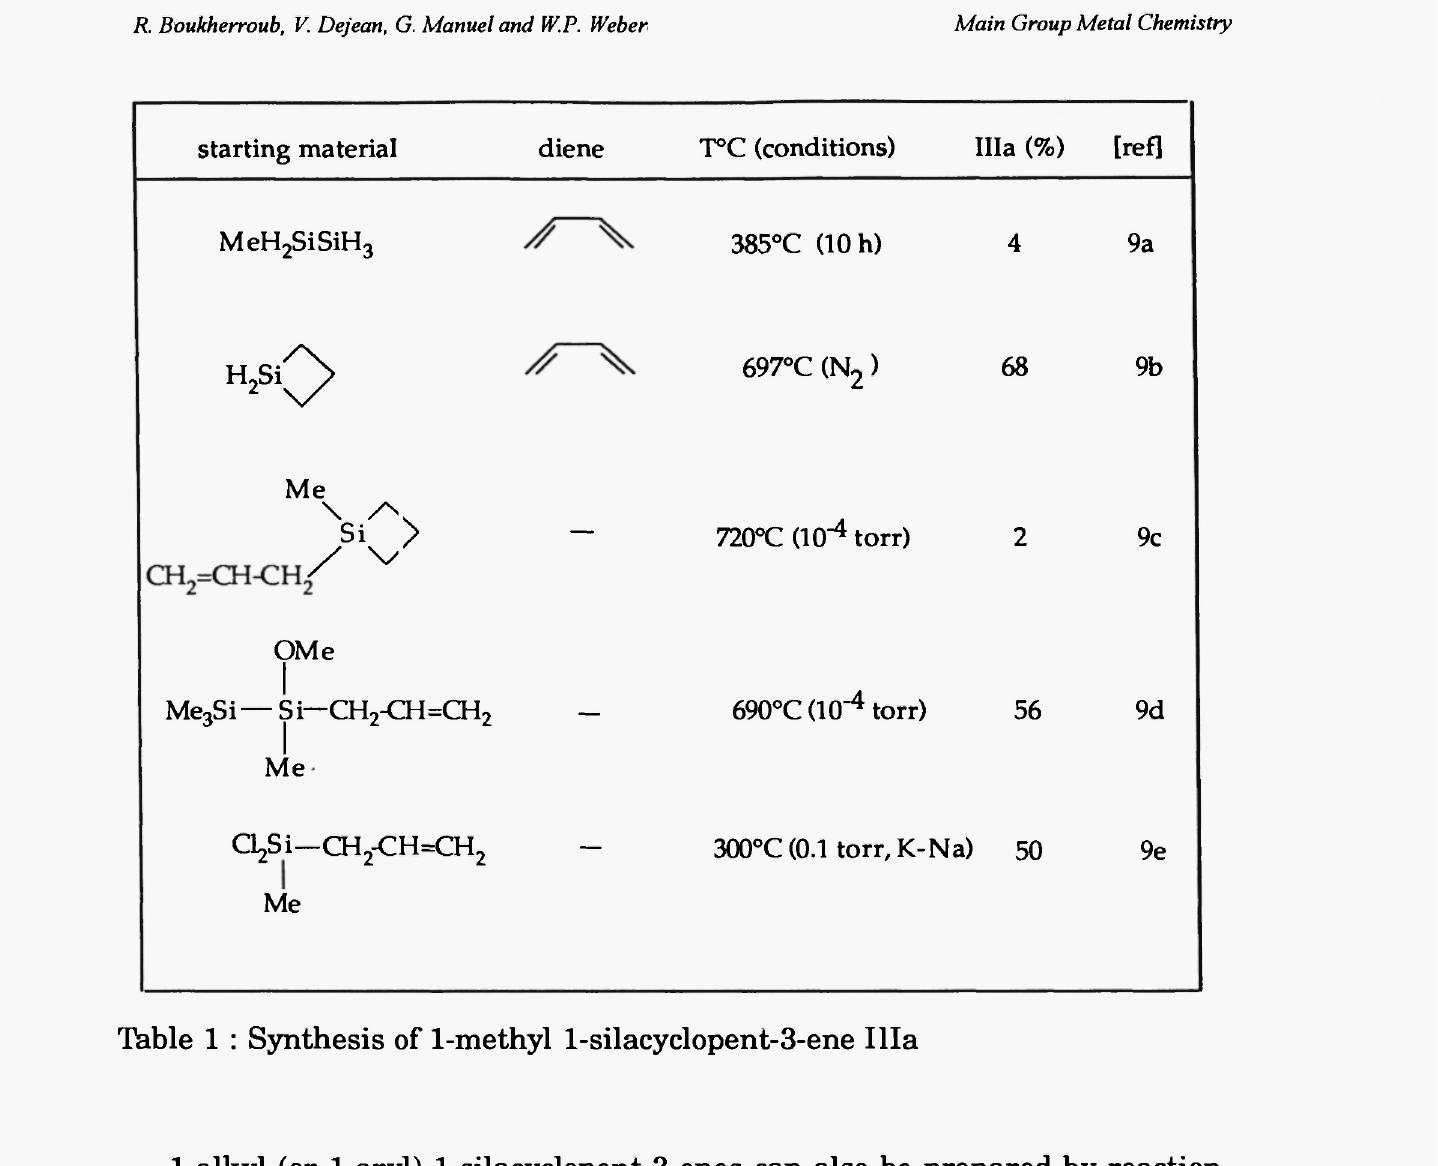
1-alkyl (or 1-aryl) l-silacyclopent-3-enes can also be prepared by